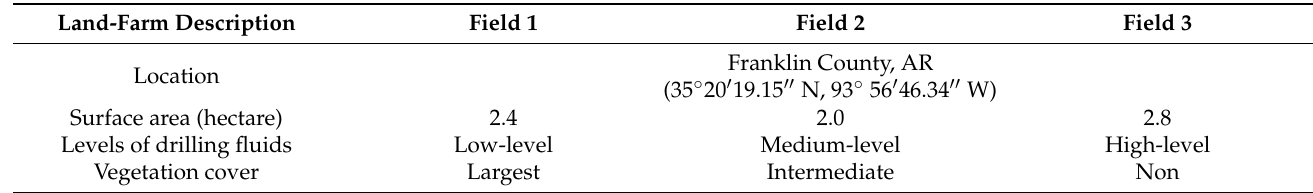
Table 1. The summary of the land-farm description in the study area.